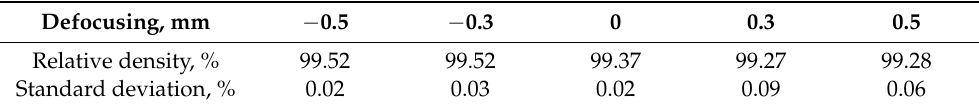
Table 3. The relative density of SLMed IN 625 as a function of defocusing amounts.